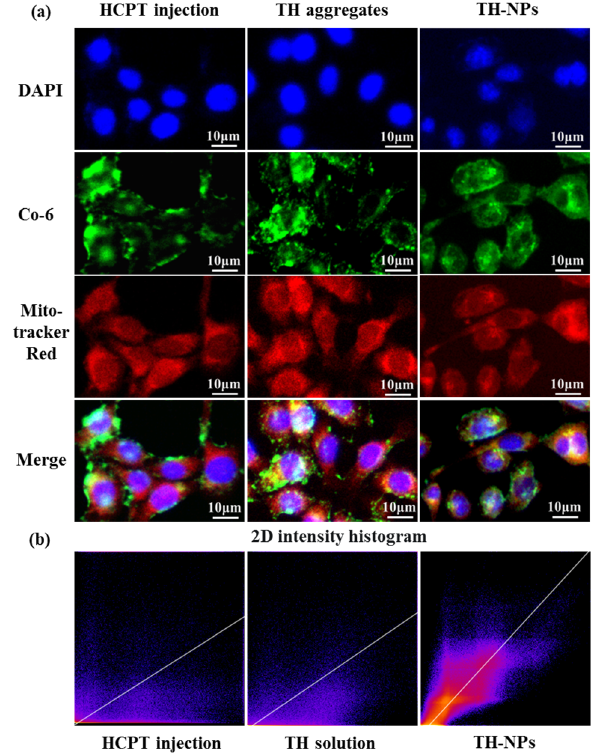
Figure 9. Co-localization analysis. The red fluorescence is the staining of the mitochondria in 4T1 cells, the green fluorescence is coumarin-labeled HCPT injection, TH aggregates and TH-NPs. The blue fluorescence is DAPI ( a ) 2D intensity histogram (orange points represent correlated part) ( b )